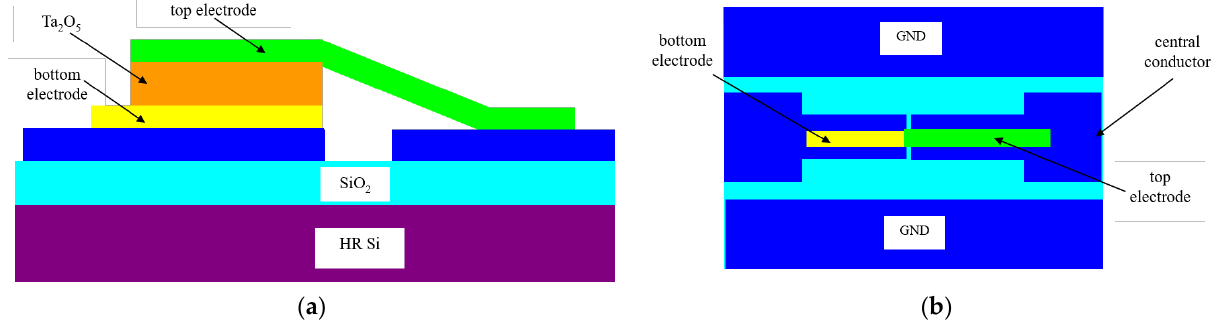
Figure 2. Schematic representation of the filament memristor and its states.